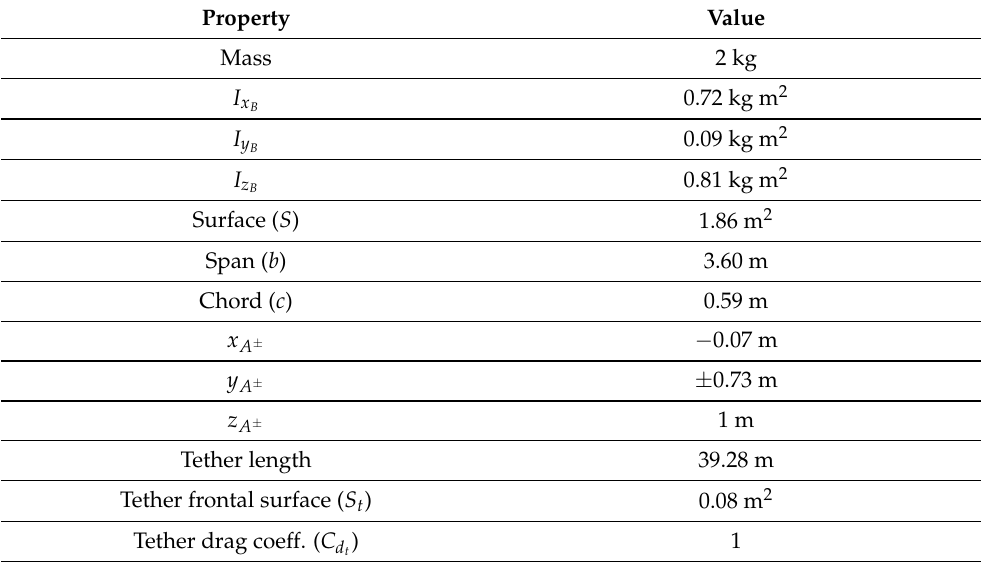
Table 1. RFD kite physical